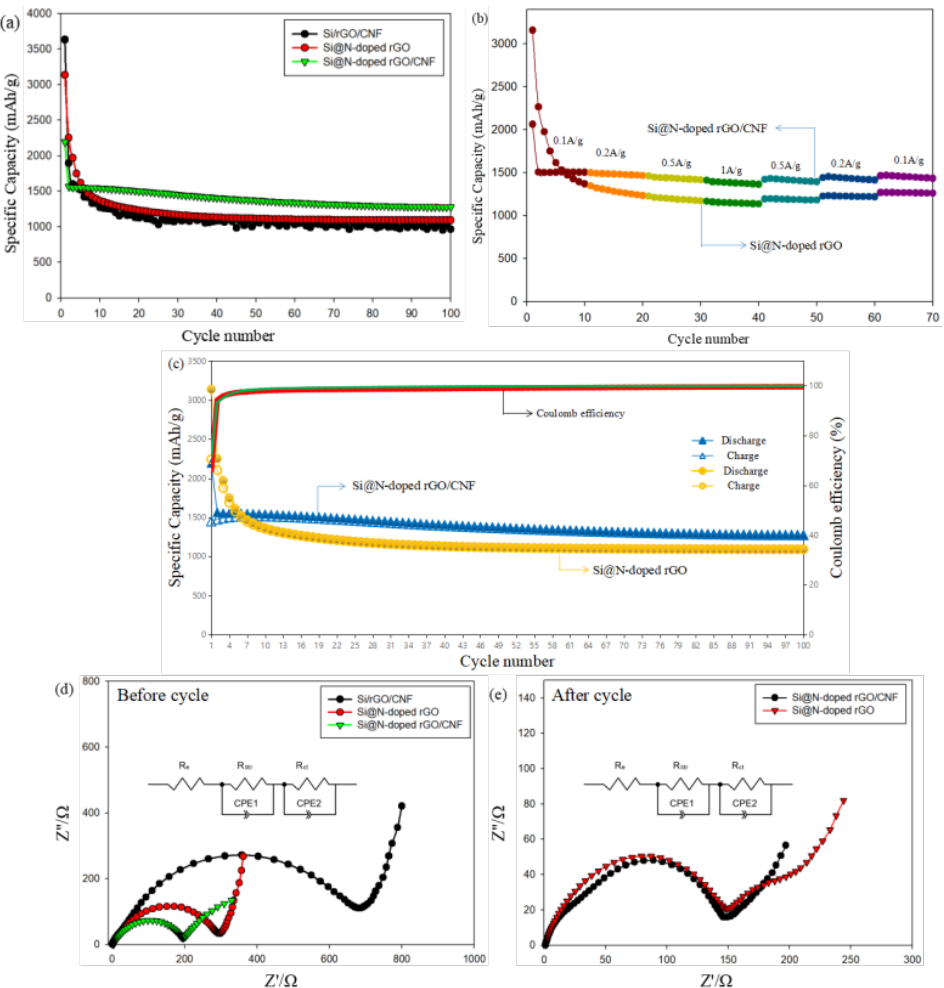
Figure 8. ( a ) Cycling performances of the synthesized Si/CNF/rGO, Si@N-doped rGO, and Si@N- doped rGO/CNF composite electrodes at a current density of 0.1A·g −1 , ( b ) Rate performances of Si@N-doped rGO and Si@N-doped rGO/CNF electrodes under different current densities, ( c ) Charg- ing and discharging cycle performance and Coulomb efficiency of Si@N-doped rGO and Si@N-doped rGO/CNF electrodes, ( d ) Nyquist plots and electrochemical impedance spectra of the Si/CNF/rGO, Si@N-doped rGO, and Si@N-doped rGO/CNF composite electrodes before the cycle. ( e ) Nyquist plots and electrochemical impedance spectra of the Si/CNF/rGO, Si@N-doped rGO, and Si@N-doped rGO/CNF composite electrodes after the cycle.